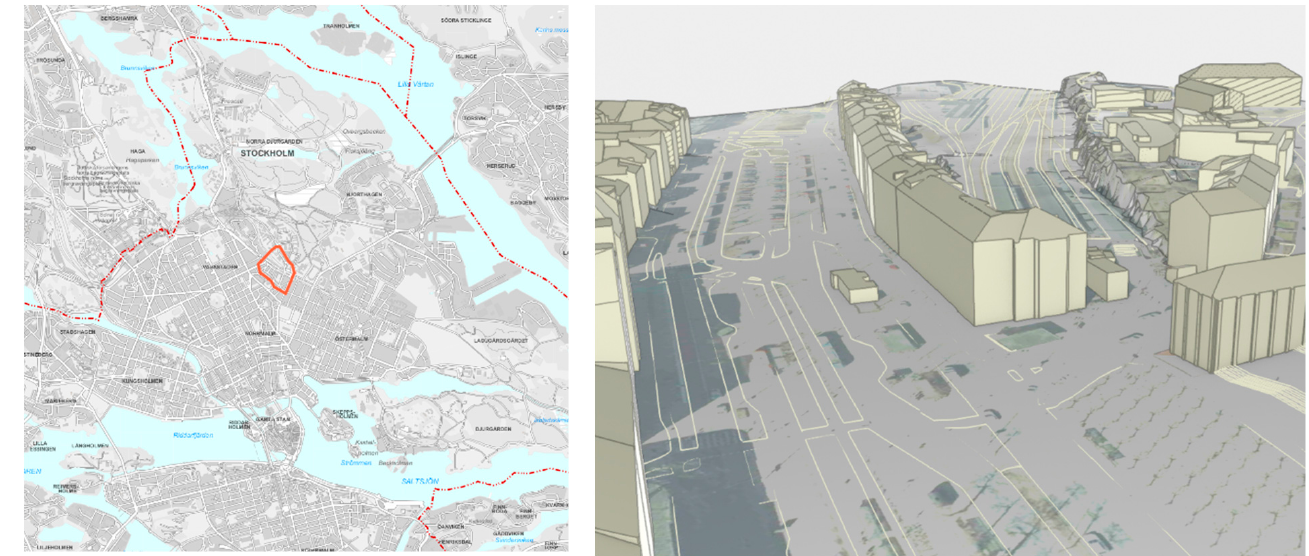
Figure 5. The area in Stockholm where the 3CIM test data were created marked in red ( left ) and the data visualised in SketchUp with a DTM and transparent orthophoto ( right ). © Stockholms stadsbyggnadskontor, Stockholm stad.